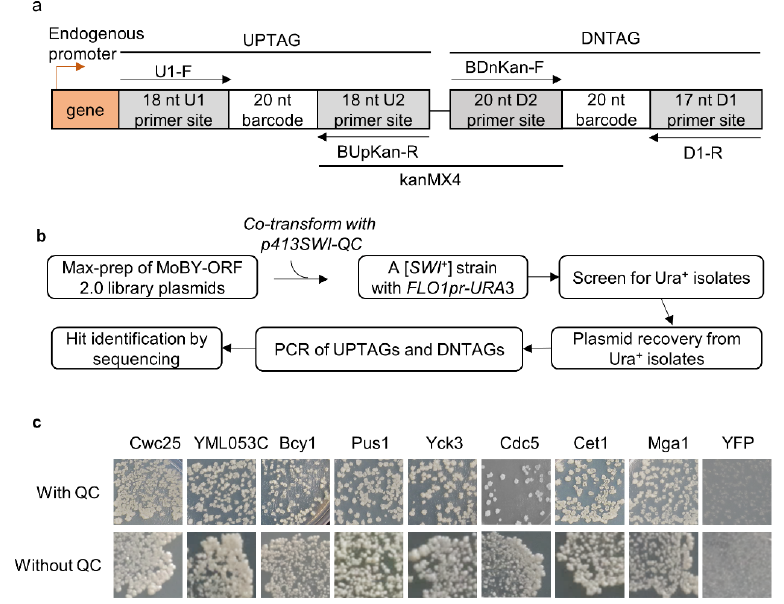
Figure 1. ( a ) Schematic illustration of the structure of a double barcoded yeast gene from the MoBY- ORF 2.0 library. Indicated primers (arrowed black lines) can be used to PCR-amplify the barcodes. The library was constructed with a 2 µ / LEU2 -based plasmid vector, with each gene driven by its own native promoter (red arrow); ( b ) flowchart of the experimental procedure for screening and identification of genes that destabilize the [ SWI + ] prion; ( c ) the loss of [ SWI + ] phenotype